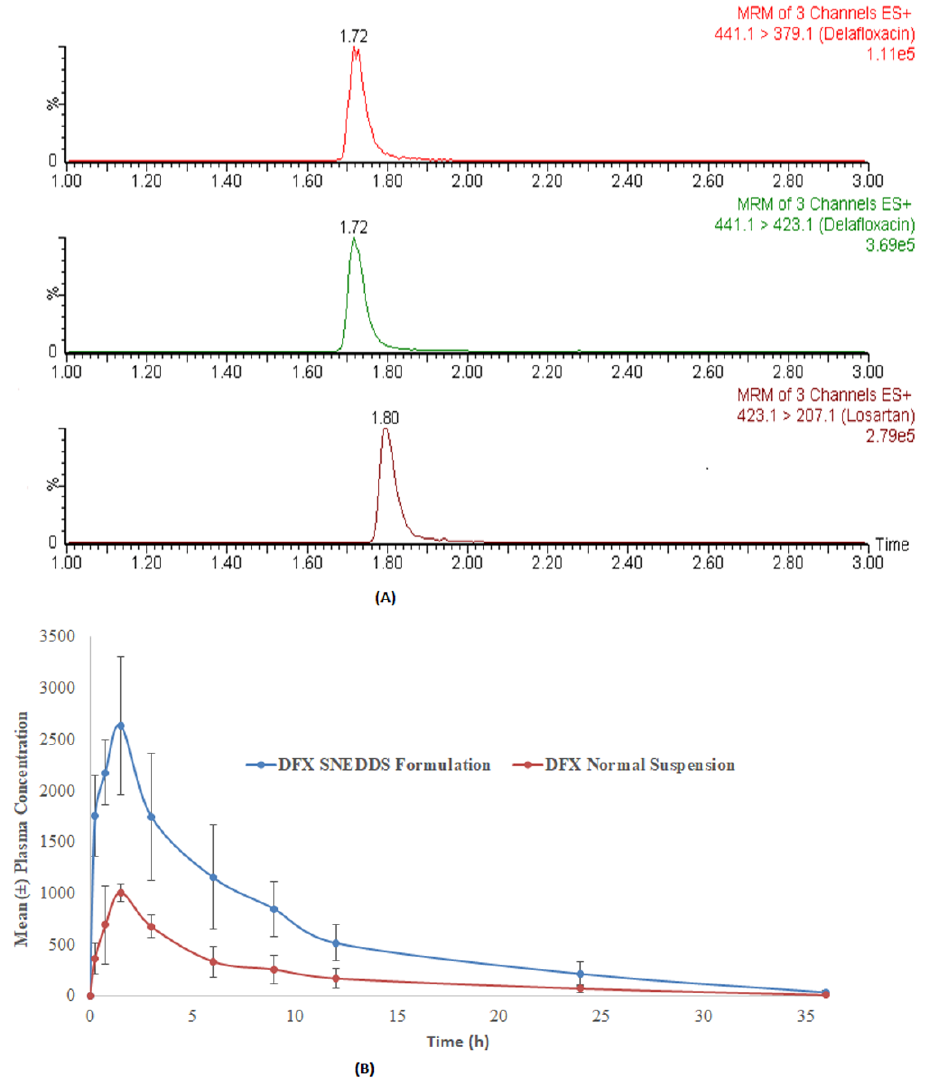
Figure 4. The representative MRM chromatograms of DFX (441.1 → 379.1 for qualifier, 441.1 → 423.1 for quantifier) and IS at one hour after oral administration of normal suspension (40 mg/kg) in rats ( A ) and the comparative (mean ± SD) plasma concentration-time profile of DFX after oral administration of DFX at a normal suspension and SNEDDS formulation ( B ).